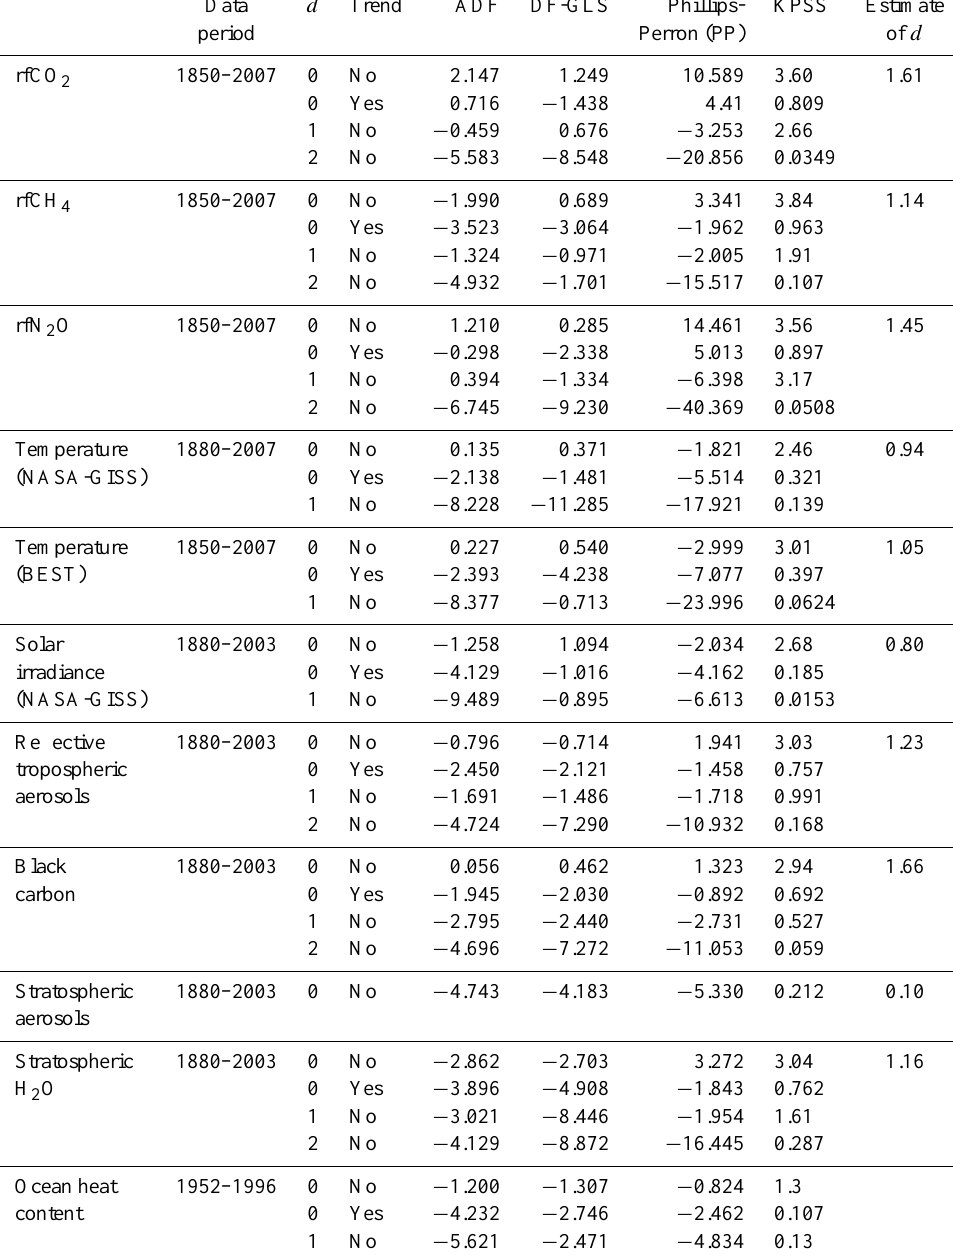
Table 1. Stationarity tests for forcings and